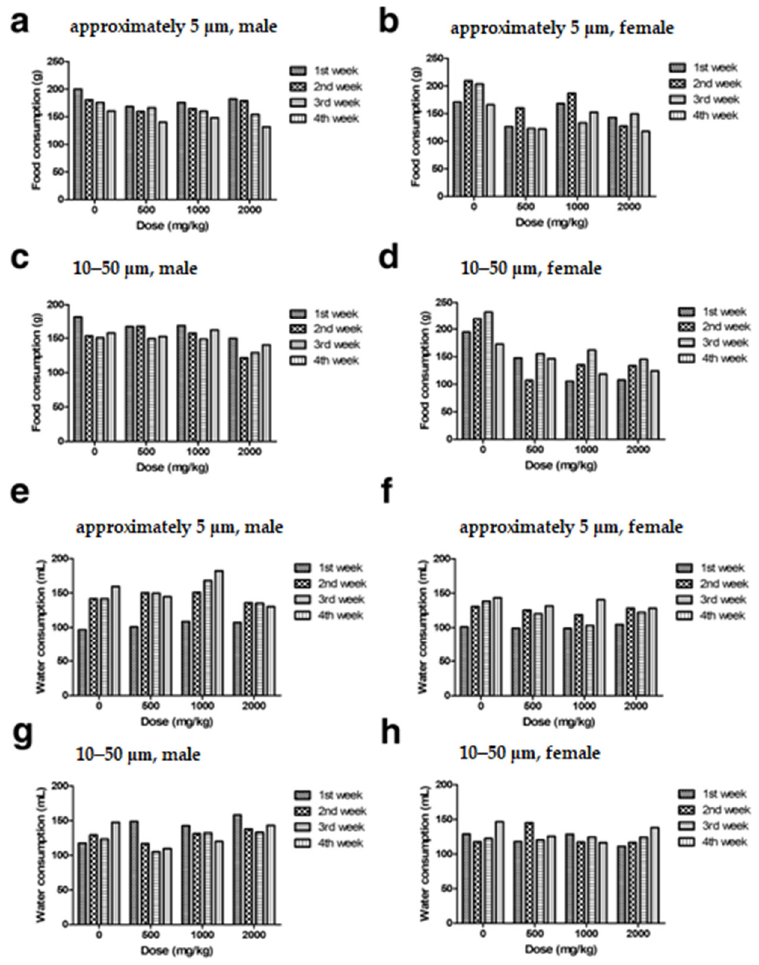
Figure 4. Male and female food and water consumption changes during the four-week repeated-dose toxicity study of approximately 5 µ m ( a , b , e , f ) and 10–50 µ m ( c , d , g , h ) PTFE microplastics. Table 1. Clinical pathology analysis of the 28-day repeated oral dose toxicity study. Male and